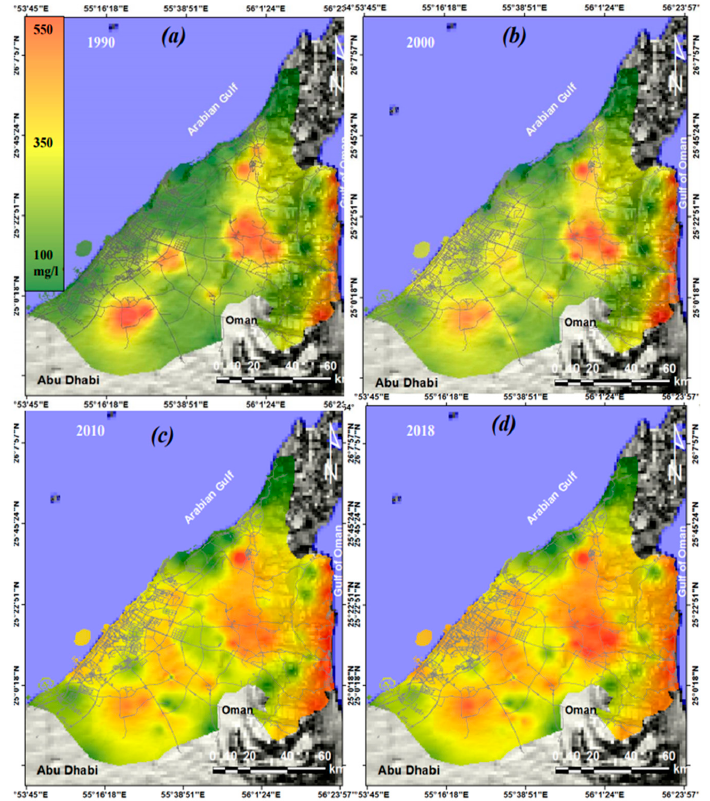
Figure 11. Regional spatial and temporal variations of nitrate concentration in groundwater across the study area for the years 1990, 2000, 2010, and 2018.